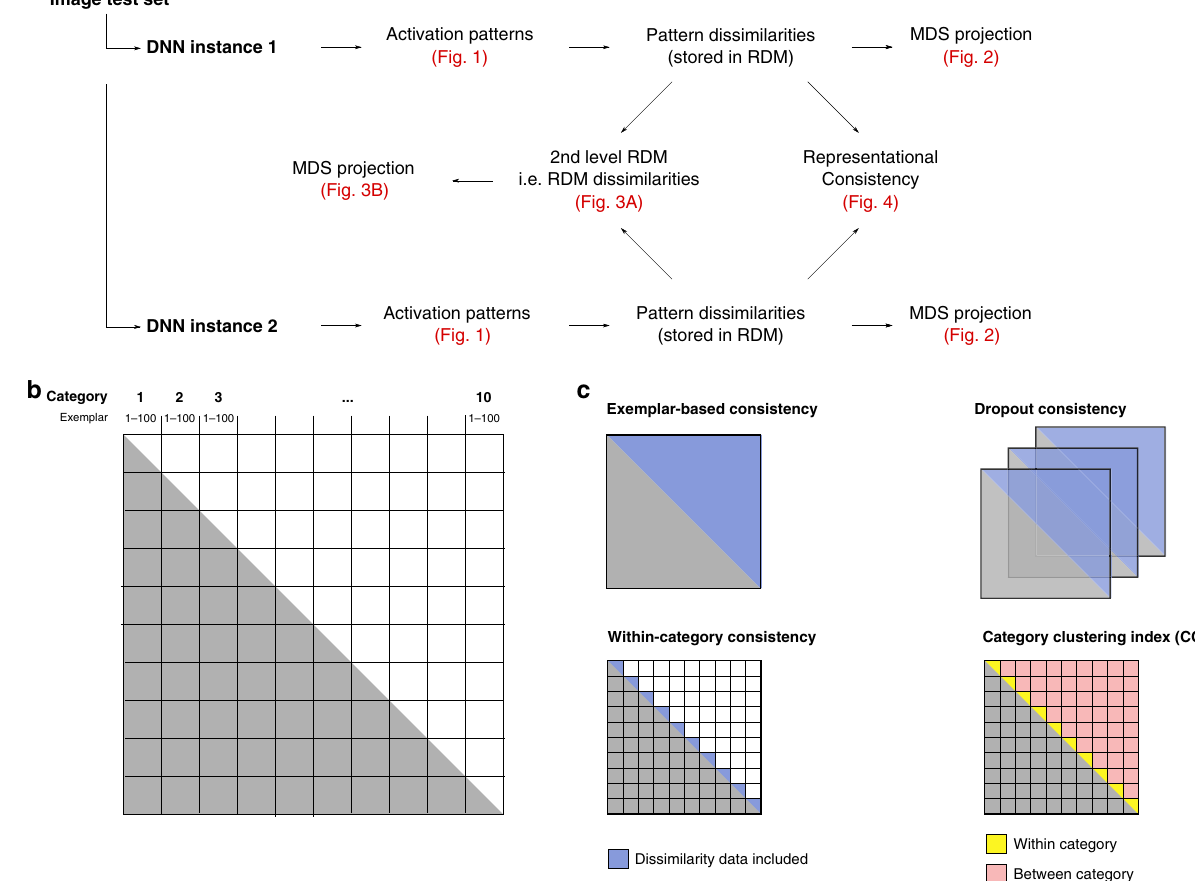
Fig. 10 Analysis pipeline details. a Overview of the different analysis steps taken to produce Figs. 1 – 4. Test images were processed by individual network instances. These activation vectors were used to compute RDMs for each network instance and layer. These distance matrices were used for MDS projection and as input to (i) representational consistency estimates, and (ii) 2nd level RSA analyses in which RDMs instead of activation patterns are compared. The second-level RDMs were projected into 2D using MDS. b Overview of the fi rst-level RDM structure. These RDMs are of size 1000 × 1000, depicting the activation vector distances for 100 instances of 10 object categories. c Our analyses focus on different aspects of the RDM shown in b . Exemplar-based consistency uses all pairwise differences, whereas within-category consistency focuses on distances among exemplars of the same category only. Consistency with dropout extracts multiple RDM samples and subsequently uses their average to compute consistency. Finally, our category clustering index contrasts distances among category exemplars categories (shown in yellow) with distances between exemplars of different categories